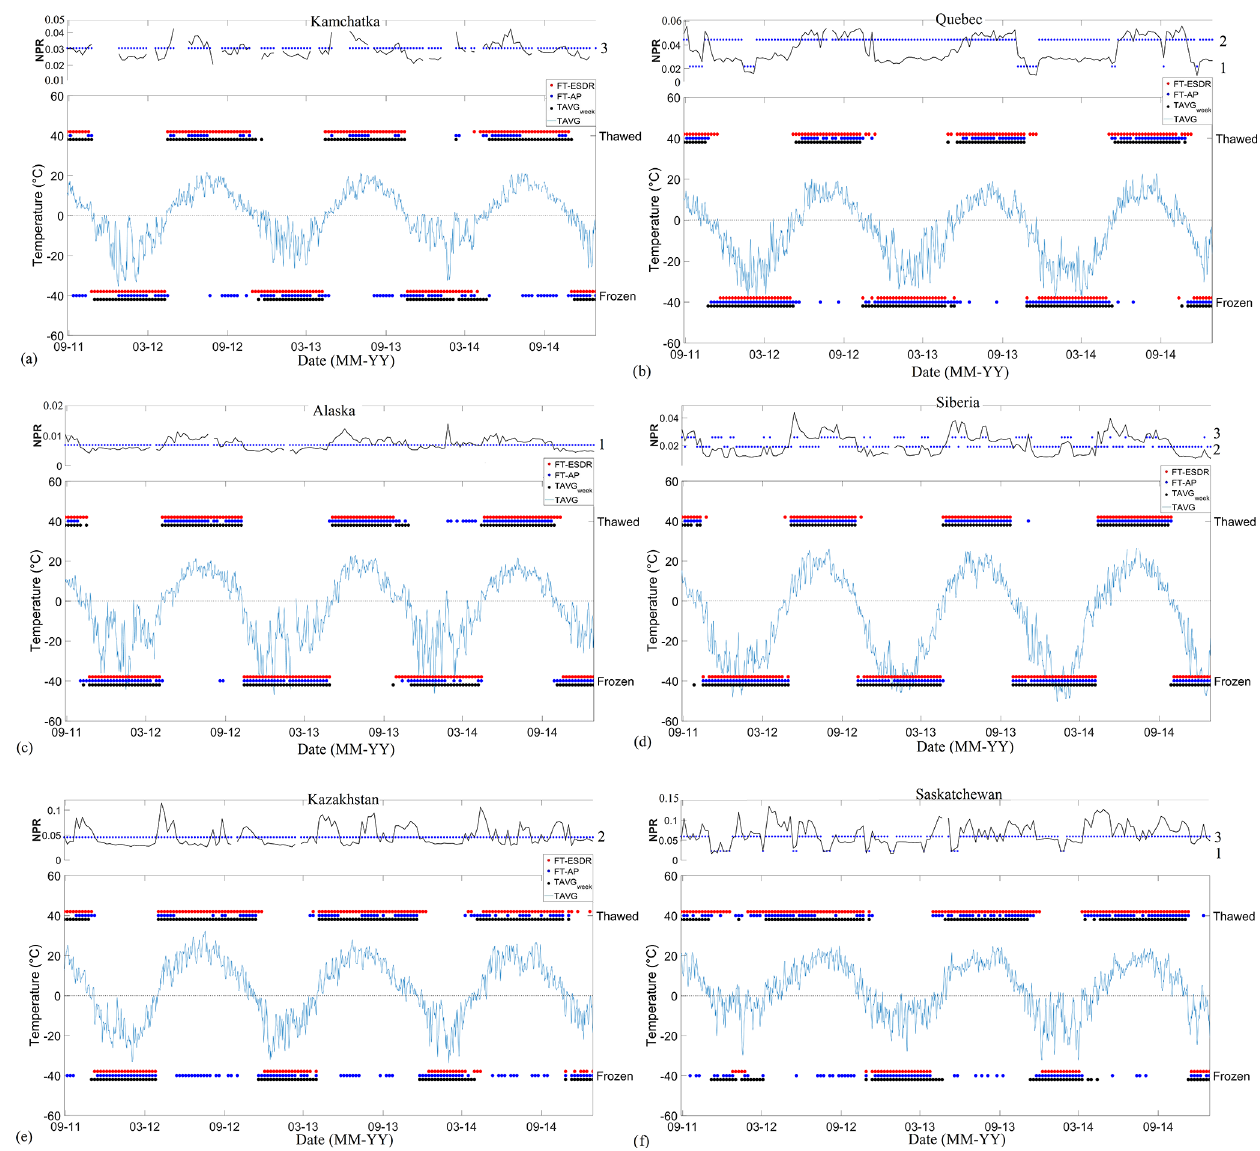
Figure 6. FT detection for each reference site (see Table 2), with FT-ESDR (red dots) and FT-AP (blue dots) against surface air temperature (black dots and blue line) in (a) Kamchatka, (b) Quebec, (c) Alaska, (d) Siberia, (e) Kazakhstan and (f) Saskatchewan. NPR series (top of each panel) contain the combination of available Aquarius observations following the prioritization of radiometer 2, radiometer 1 and then radiometer 3 (Sect. 2.1). NPR threshold values (blue dots) are shown according to Eq. (1), with the corresponding beam number shown on the